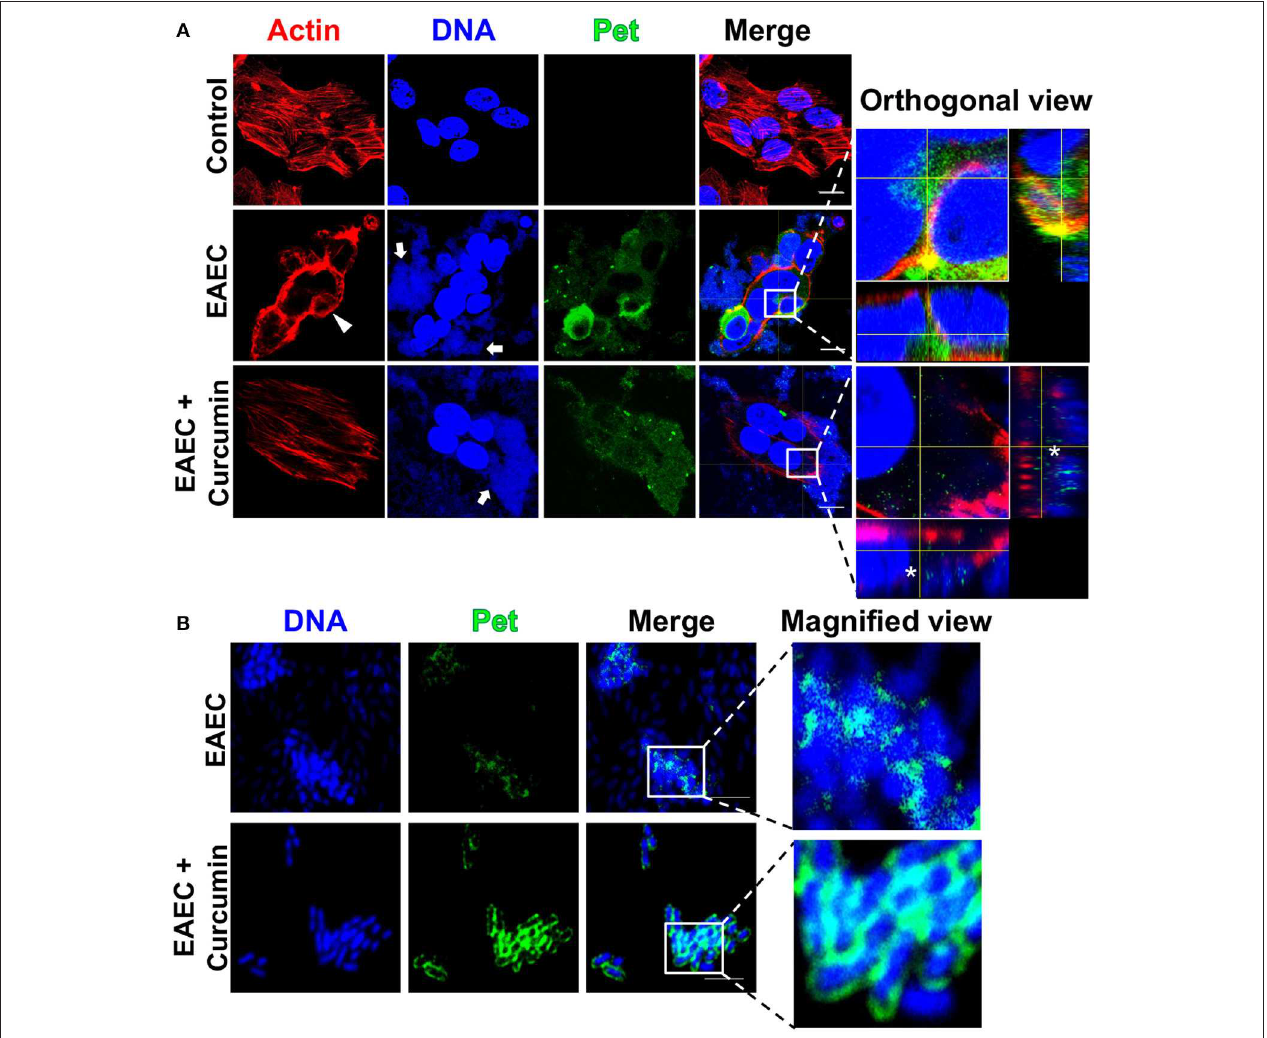
FIGURE 5 | Curcumin blocks the cytotoxic effect induced by EAEC (rounding cells) in HEp-2 cells by inhibiting Pet internalization without affecting bacterial adherence to epithelial cells. Confocal microscopy of HEp-2 cells infected with EAEC (MOI 10) during 2h (A) and a magnified view of bacteria-only (B) in the presence or absence of Curcumin (16 µ g/mL). Uninfected cells were used as control. After infection, cells were washed, fixed, permeabilized, and stained with rhodamine-phalloidin for actin filaments and TO-PRO-3 for DNA detection. Pet secretion and internalization was detected by immunofluorescence using an anti-Pet passenger domain antibody followed by biotin-SP-conjugated goat anti-rabbit IgG and DTAF-conjugated streptavidin. The preparations were analyzed and documented with a confocal microscope (63 × ). Middle sections of the three channels were analyzed in z -stack, and the representative orthogonal views are shown with a higher magnification. Bacteria-only in the presence of curcumin are washed then stained for Pet as described above. A magnified view of a merge image is shown. Arrows indicate the aggregative adhesion pattern of EAEC on HEp-2 cells. Arrowheads indicates the cell rounding effect and an asterisk denotes the absence of Pet in HEp-2 cells; scale bar 15 µ m in (A) . Scale bar 5 µ m in (B)